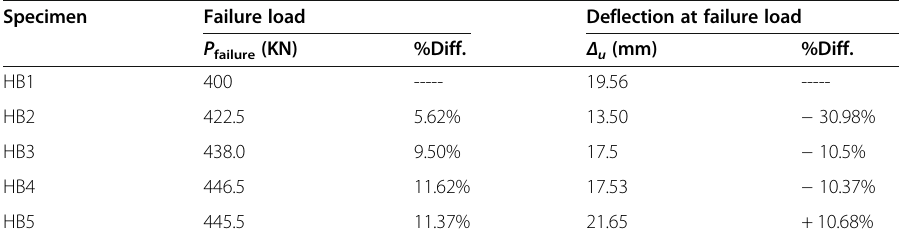
Table 11 Comparison between the strength characteristics of specimens Specimen Failure load Deflection at failure load P failure (KN) %Diff.